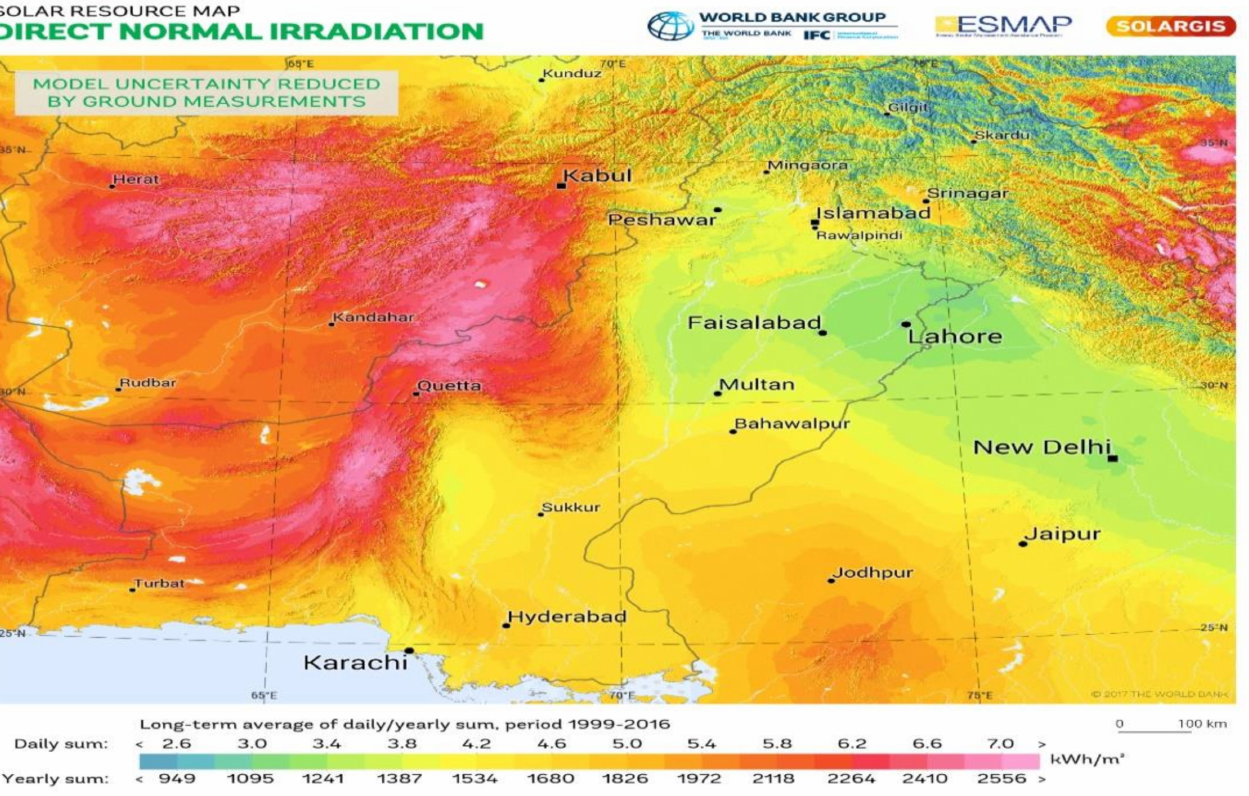
Figure 1. Solar PV power potential map [22].